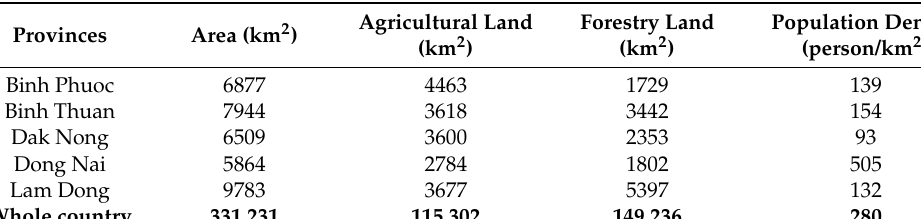
Table 1. Study site description [28].